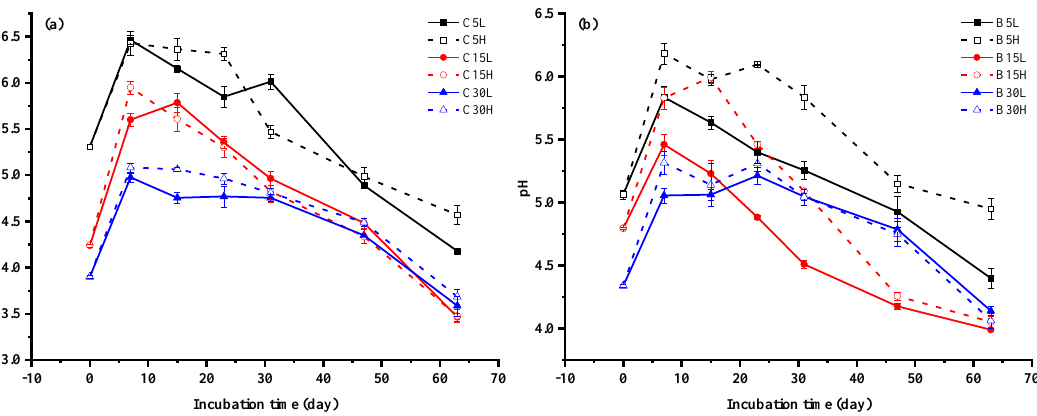
Figure 1. Soil pH during 71-day incubation period; ( a ) Changsha, ( b ) Baisha; L: 50% WFPS, H: 80% WFPS. 5, 15, and 30 represent soil under 5-y, 15-y, and 30-y tea plantations. Error bars indicate standard deviation.